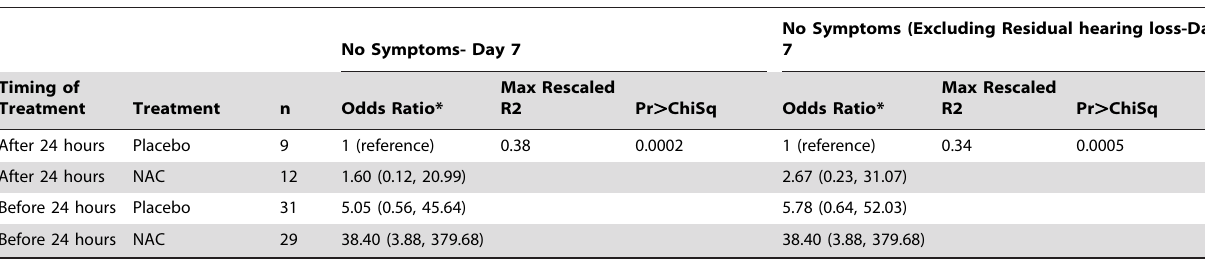
Table 4. Treatment Effects: Day 7